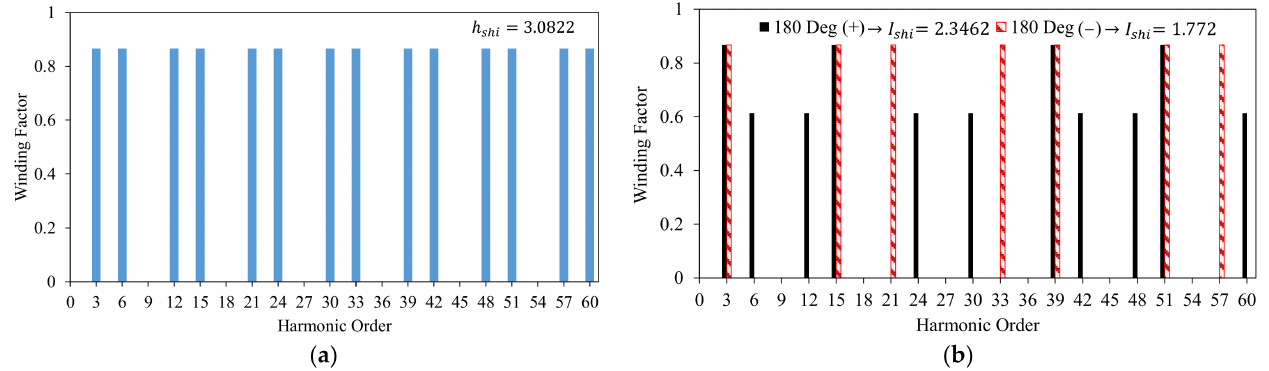
Figure 9. Comparison of winding factors: ( a ) initial (original) and ( b ) final winding factors after the phase-shifting operation.